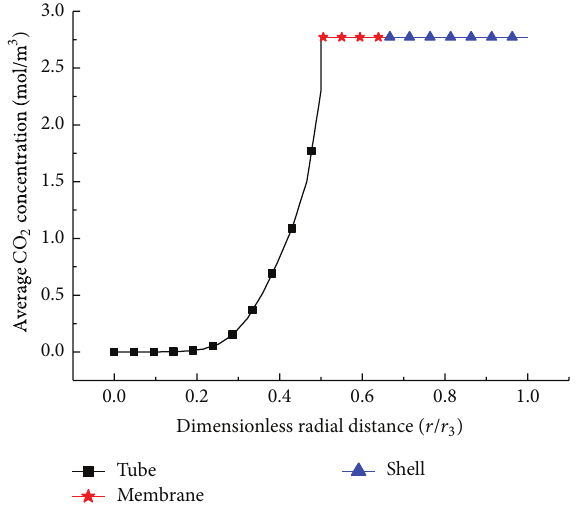
Figure 5: Concentration distribution of CO 2 in radial direction. = 4 mol m −3 , 𝐶 𝐶 0 0.5 ms −1 .